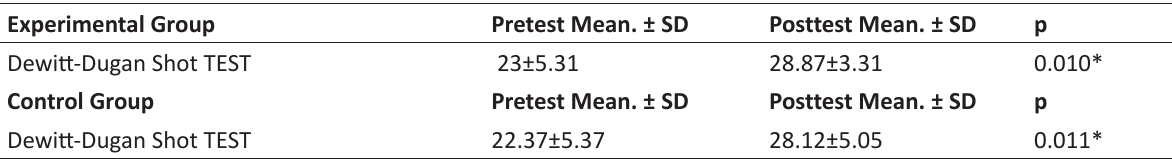
Table 3 . Comparisons of Wilcoxon Signed Ranks test data of the control and experimental group Experimental Group